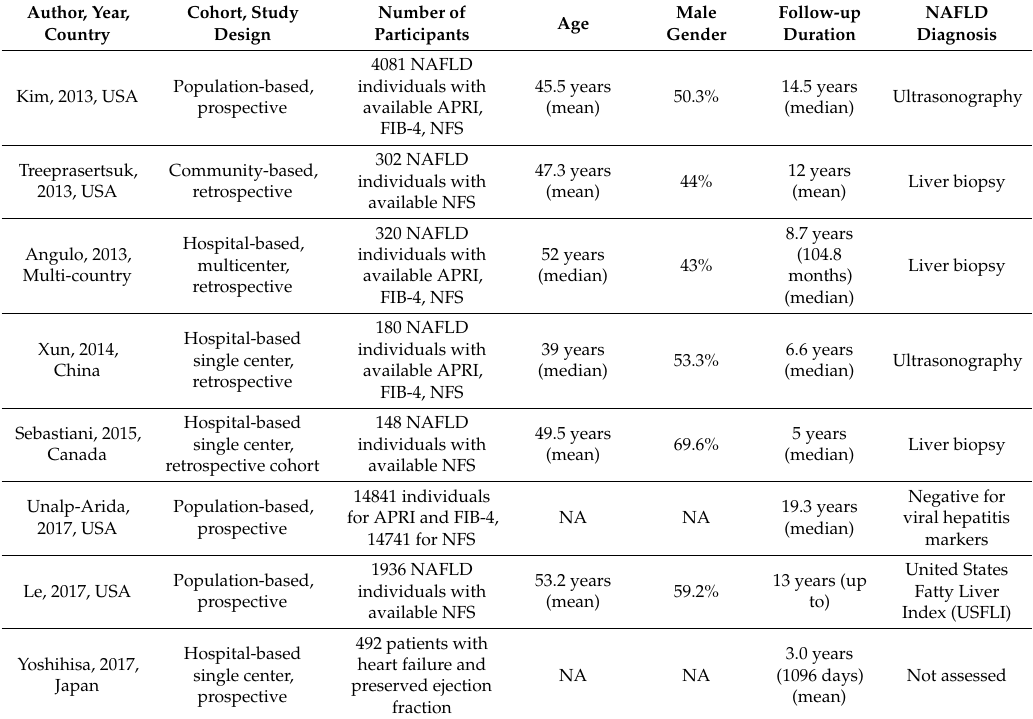
Table 1. Main features of the 8 studies included in the systematic review (NA: not